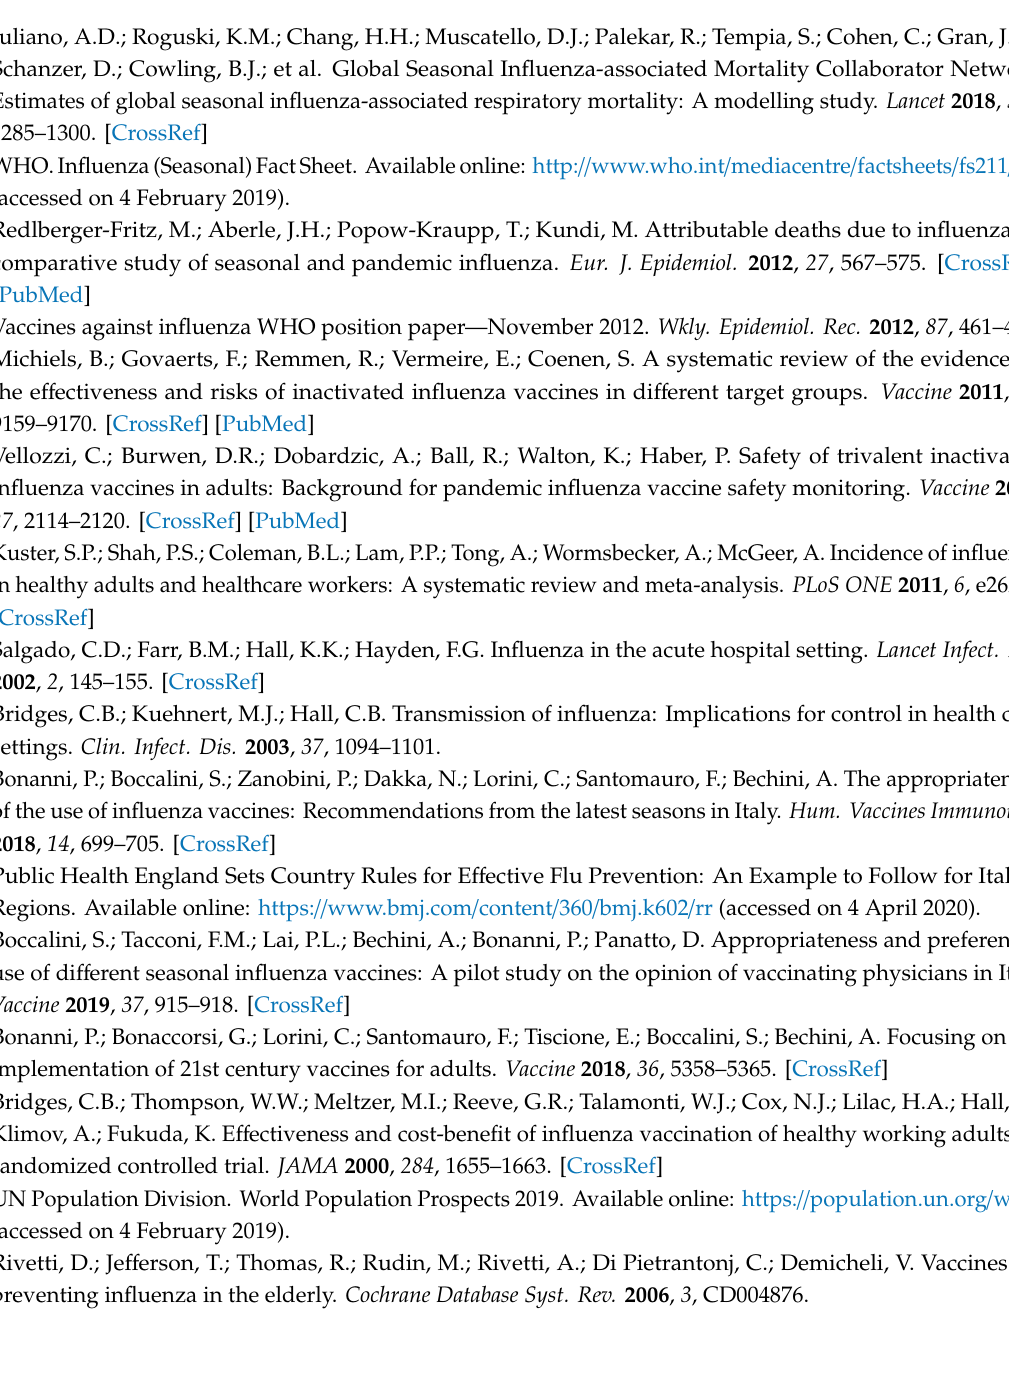
Table S1: Synthesis of the studies involving intervention and control groups and Quality Assessment (EPHPP) of each study. Table S2: Synthesis of the studies not involving intervention and control groups and Quality Assessment (EPHPP) of each